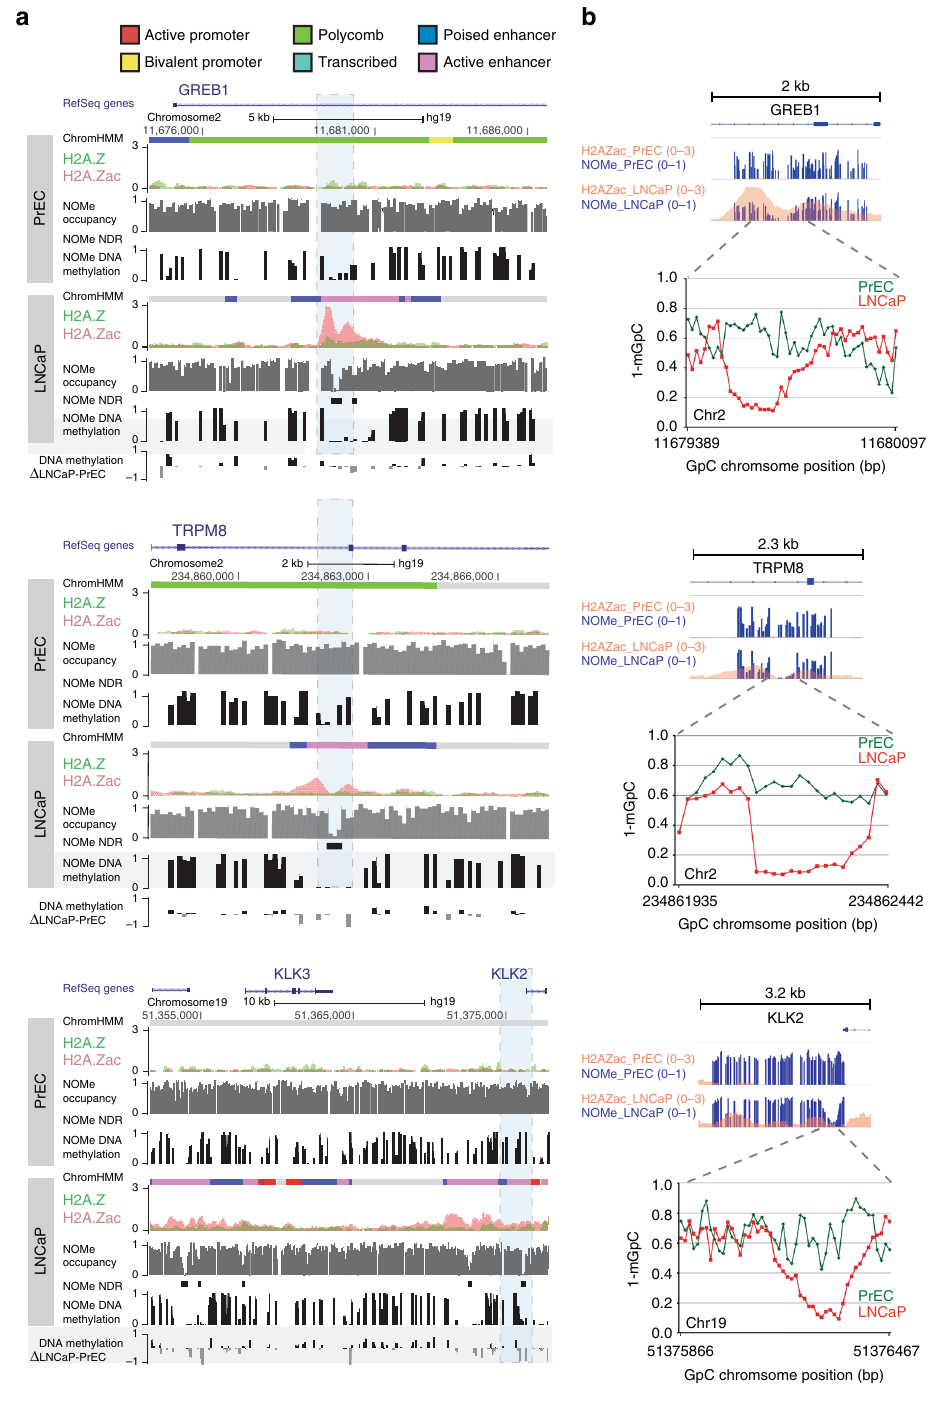
Figure 6c highlights speci fi c examples of the dynamics of H2A. Zac remodeling at AR-enhancers of known androgen-induced genes, IQGAP2 , GREB1 , and TRPM8 and Fig. 6d shows two speci fi c examples at GREB1 and TRPM8 AR-enhancers validated by targeted NOMe-seq. The data suggest that H2A.Zac nucleosomes are either more unstable or are associated with a more active nucleosome turnover in order to “ guide ” AR and facilitate nucleosome eviction or repositioning in AR